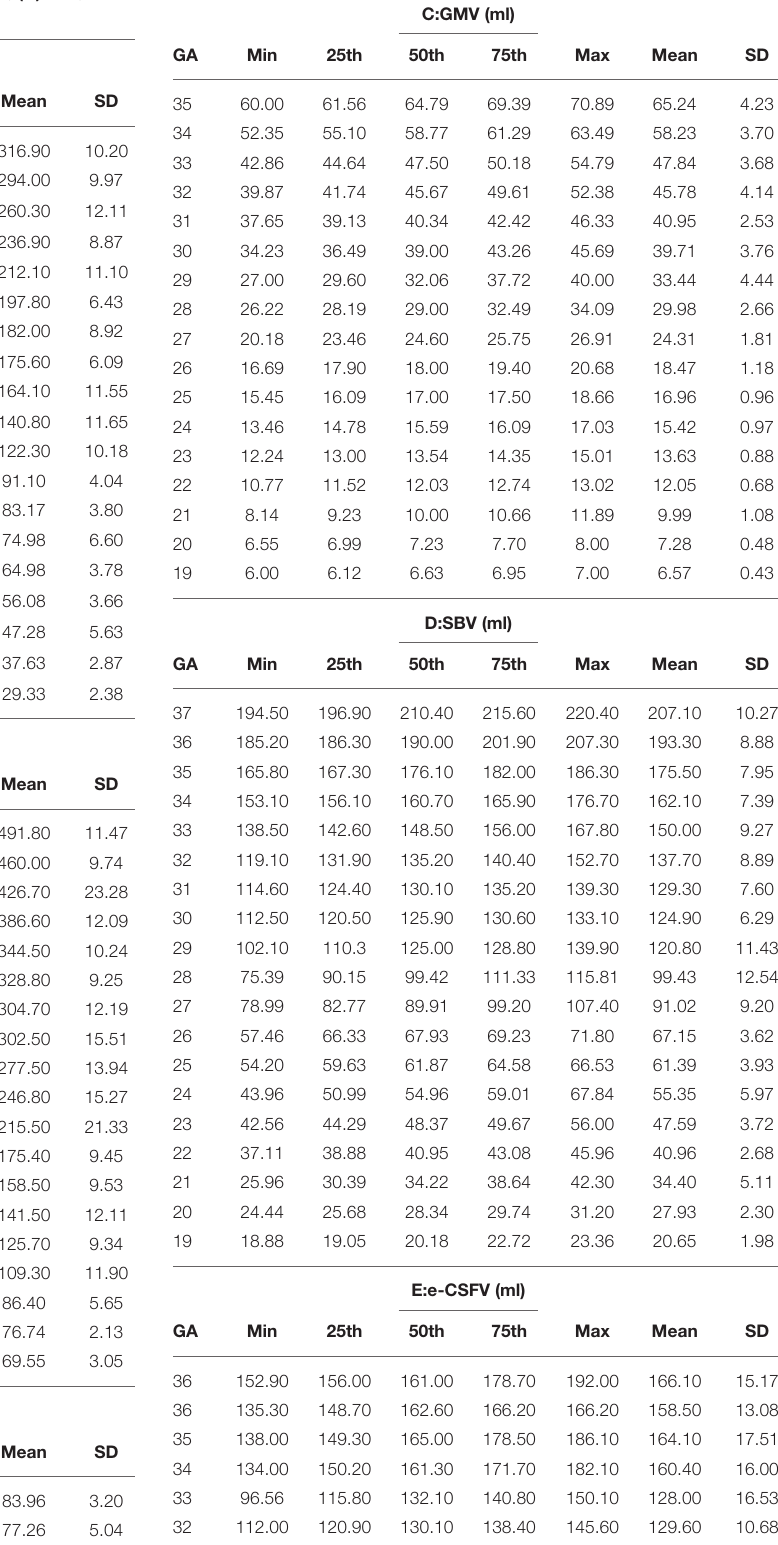
TABLE 1 | The tabular summaries of min, max, mean, 25th, 50th, and 75th centiles of (A) TBV, (B) ICV, (C) GMV, (D) SBV, (E) e-CSFV, (F) VV, (G) CBV,